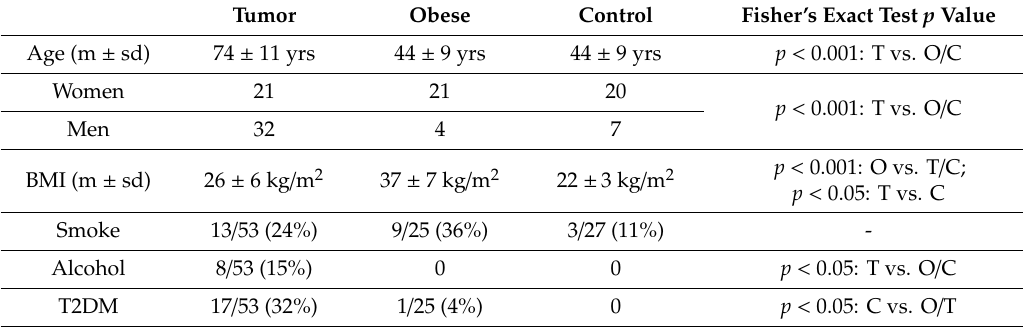
Table 1. Patients’ demographics. Abbreviations: m = mean; sd = standard deviation; yrs =